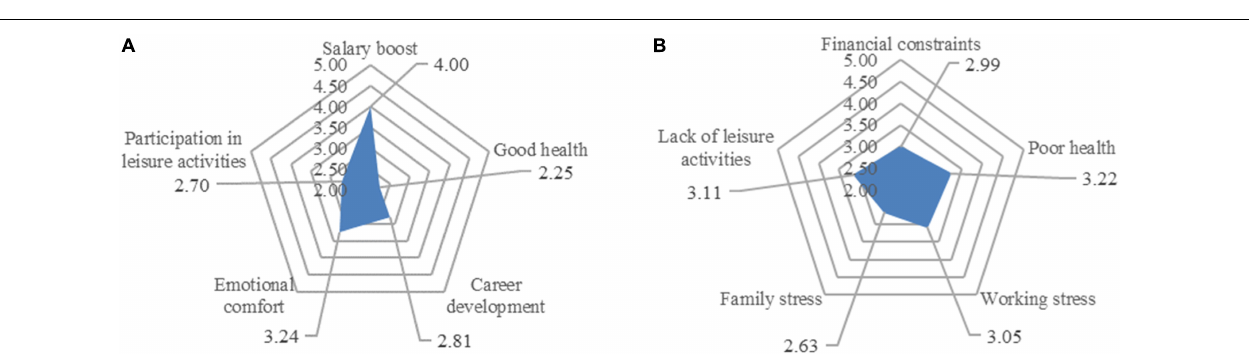
FIGURE 5 | The emotional cognition score of professional